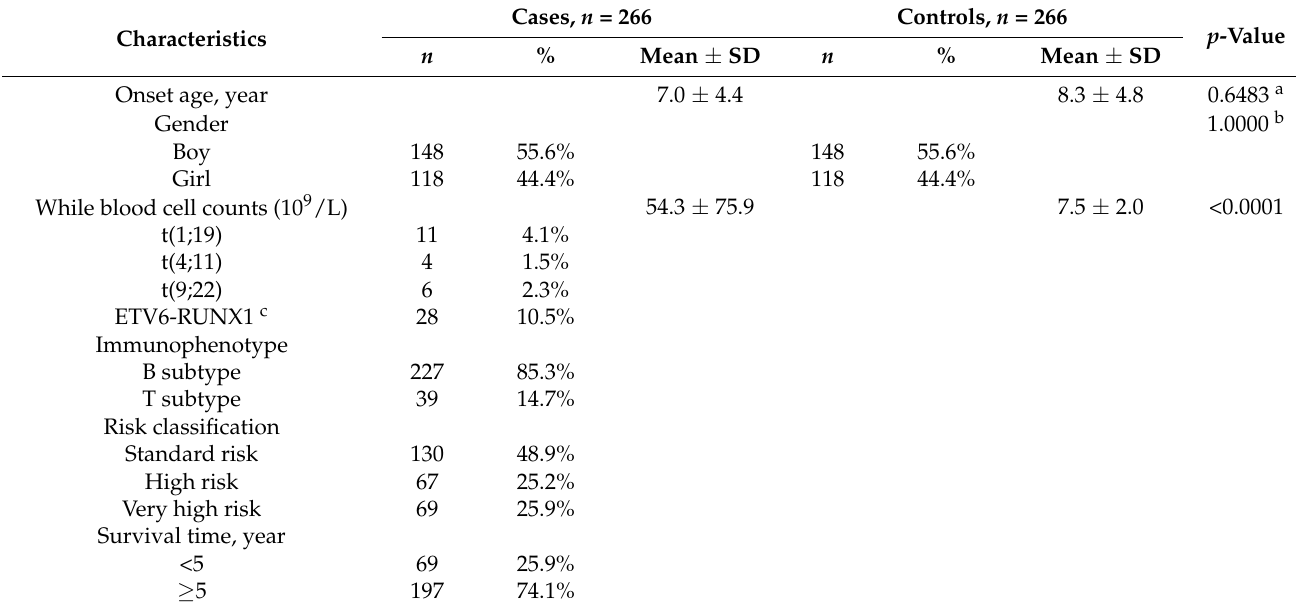
Table 1. Distribution of onset age and gender of the 266 childhood leukemia patients and 266 healthy controls. Cases, n = Characteristics